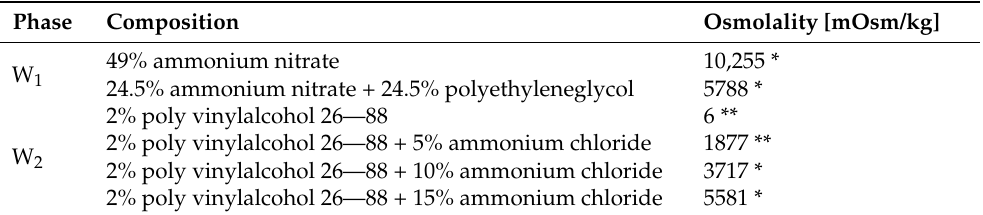
Table 1. Summary of the osmolalities of the individual aqueous emulsion phases. * These values are extrapolated. ** These values are measured.